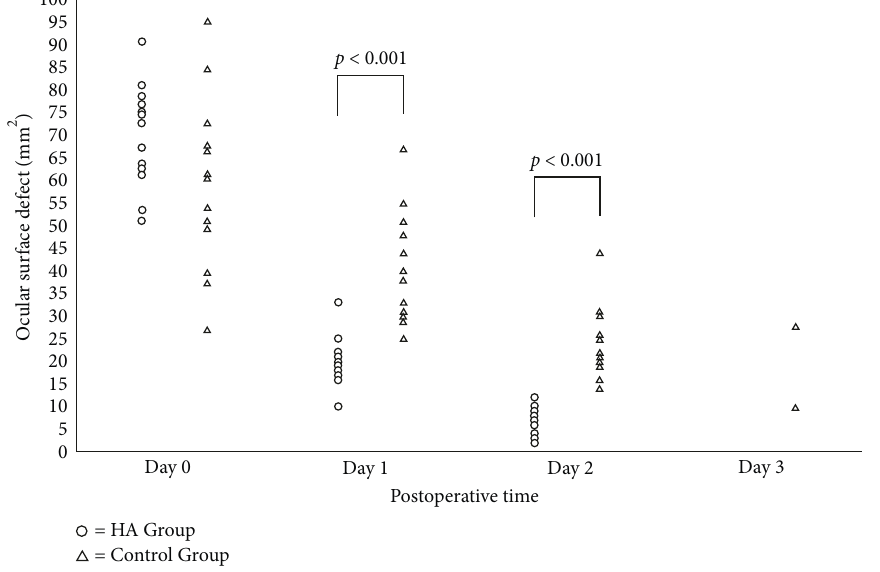
Figure 6: Area of ocular surface defect on Days 0, 1, 2, and 3 between the SH and the control